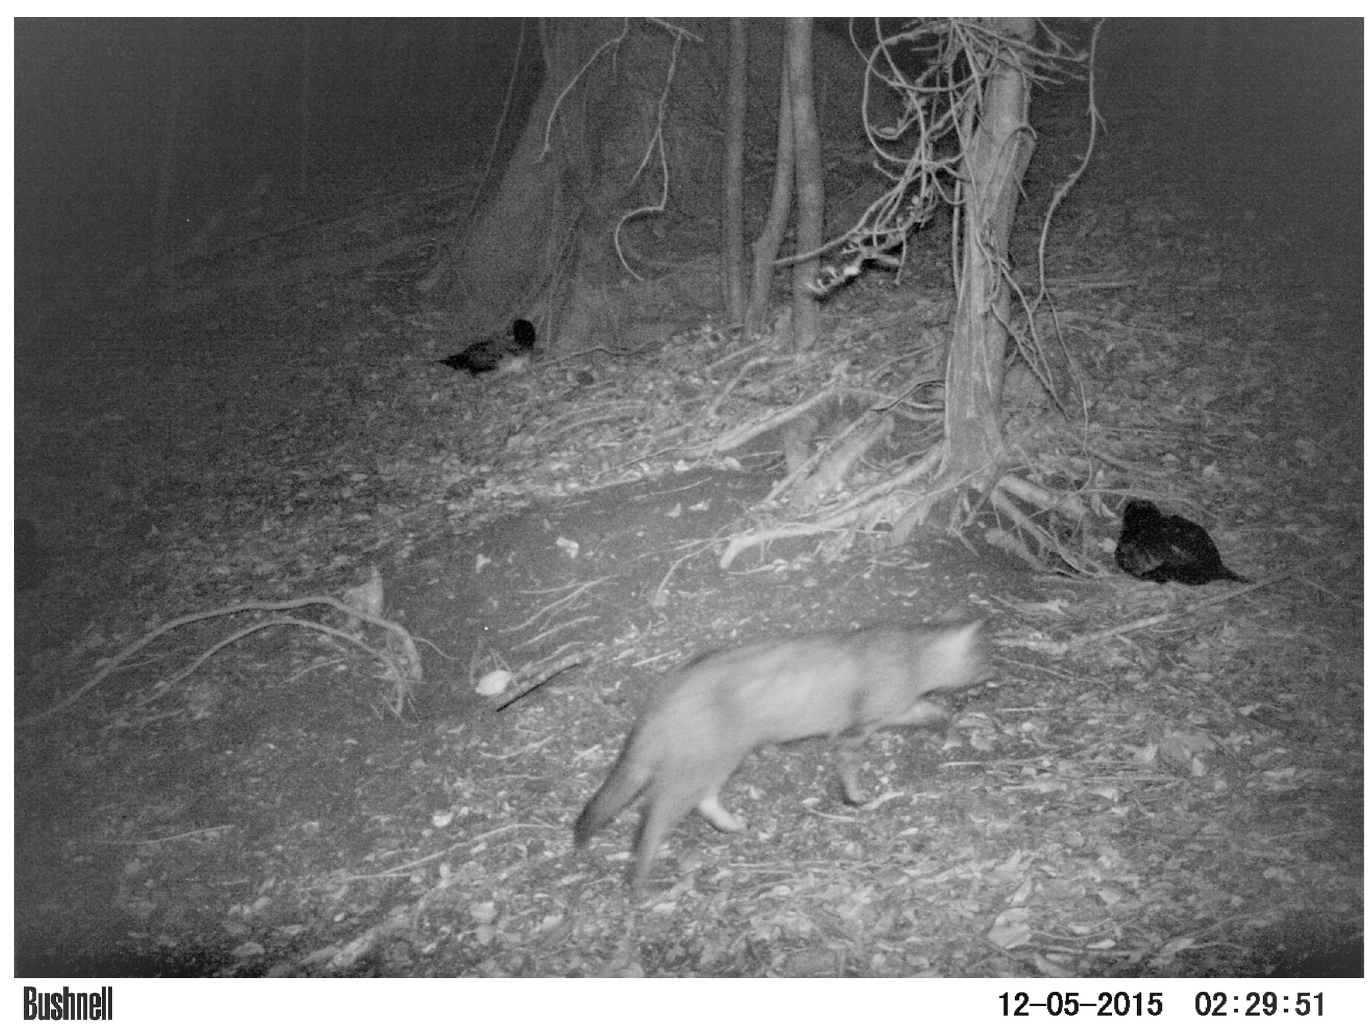
Fig 6. Trail camera image of a cat near two pink-footed shearwaters on Isla